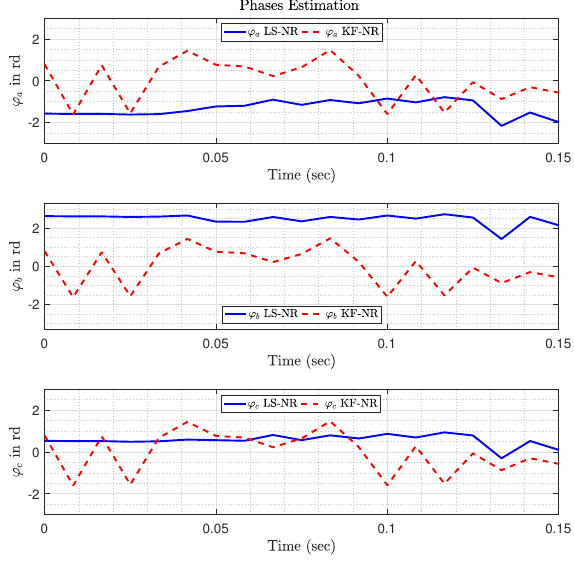
Figure 10. Phases variation of phasors: comparison between LS and KF using NRA estimations (event